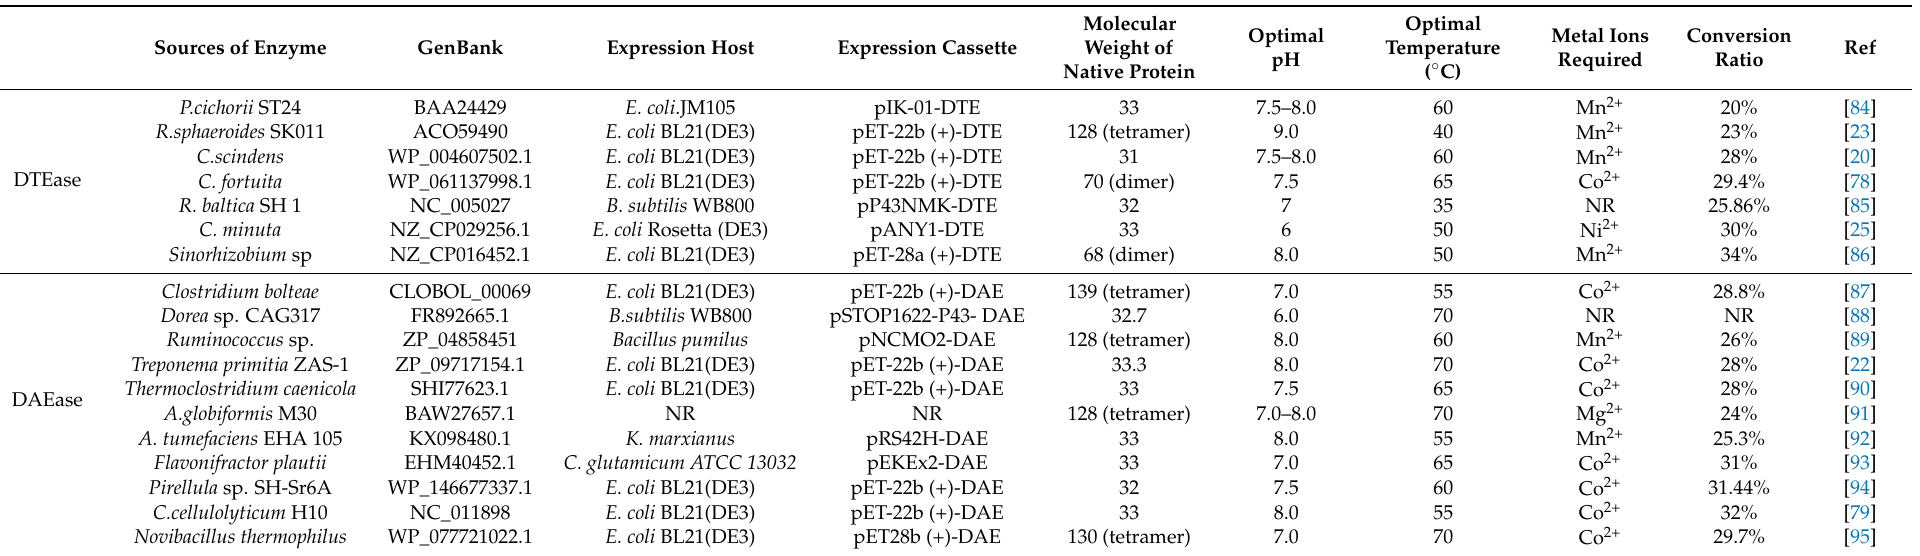
Table 3. Microbial sources and the related information for DTEases and